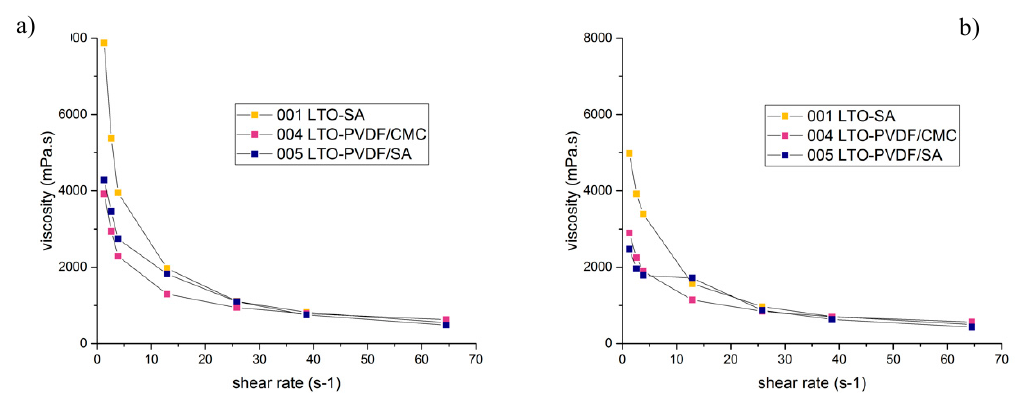
Figure 5. Viscosity as a function of the shear rate for different slurries: ( a ) directly after mixing and ( b ) after 24 h.